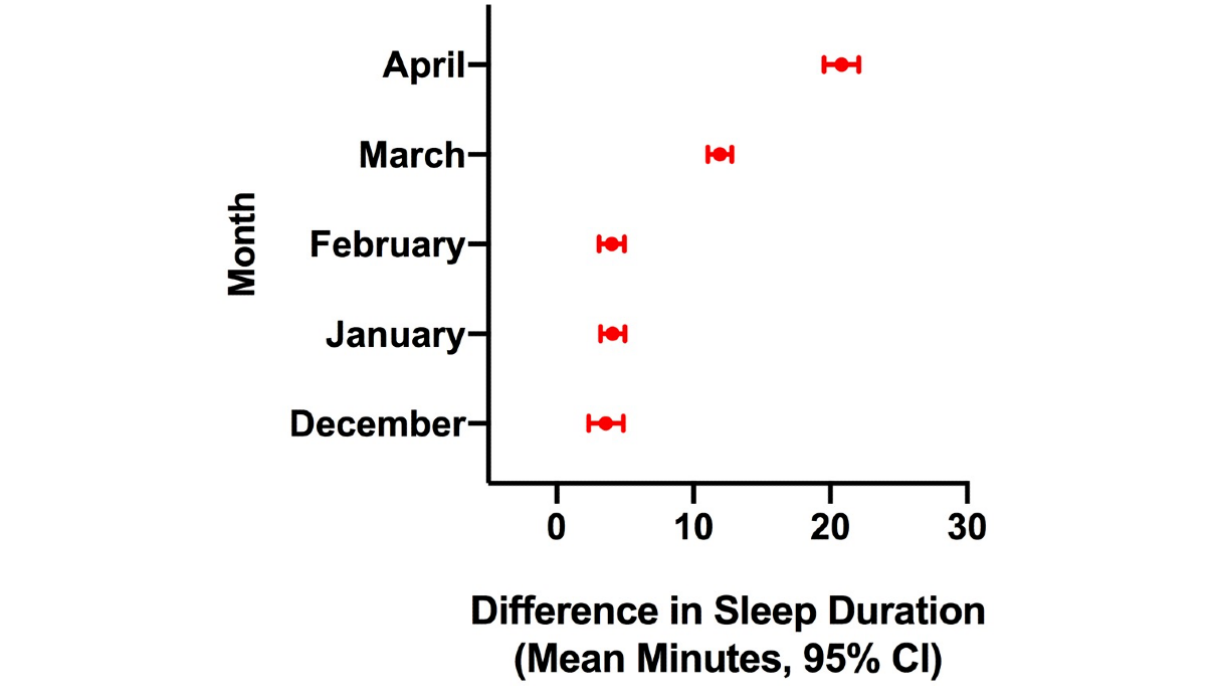
Figure 4. Difference in estimated sleep duration during the COVID-19 pandemic compared to the same month in the previous year in London.